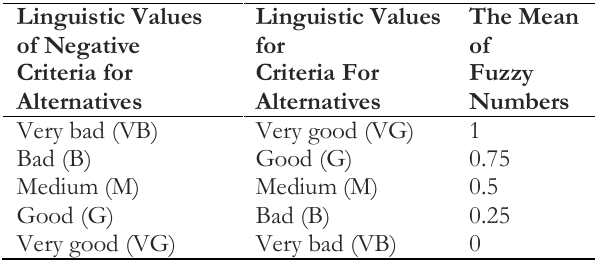
Table 1 : quality, on time delivery, cost, reliability, services, technical capabilities, location, financial status, partnership, operational control, supplier reputation, packing, background, reciprocity, flexibility, discounts, transport, and